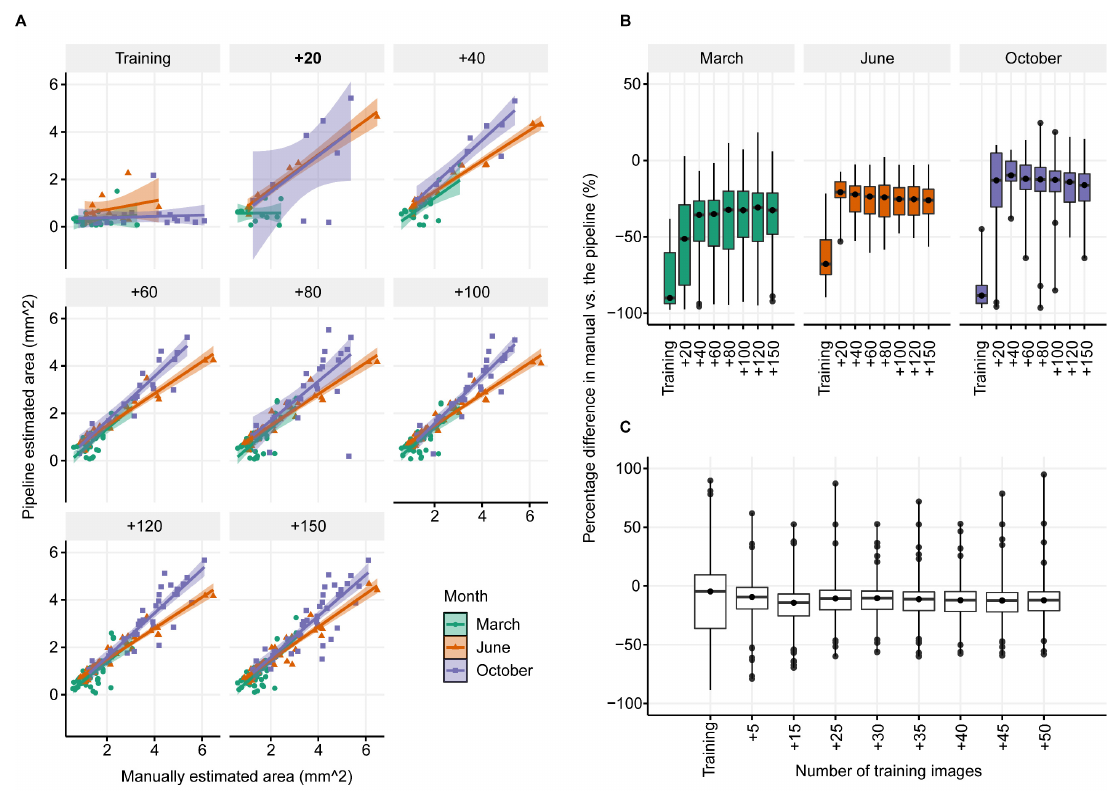
Figure 4. Assessment of machine learning image analysis pipeline for coral juvenile size. Linear regressions comparing the measured size of juveniles using manual measurements and the pipeline for tile images ( A ). The facet indicates the number of training images used. The color indicates the time point (month) in which the images are from. Boxplots showing the percentage change in area (mm 2 ) between manual measurements and the pipeline using different numbers of training images when using the tile images ( B ). The facet and color indicate the time point (month) the images were from. Boxplots of the percentage change in area (mm 2 ) between manual measurements and the pipeline using the slide images ( C ). Note that the y -axis for B and C have different scales. For ( B , C ), any point below 0 on the y -axis indicates the pipeline is under-predicting the size of the juveniles relative to the manual measurements. If the point is above 0 then the pipeline is over-predicting the size of the juvenile relative to the manual measurements.